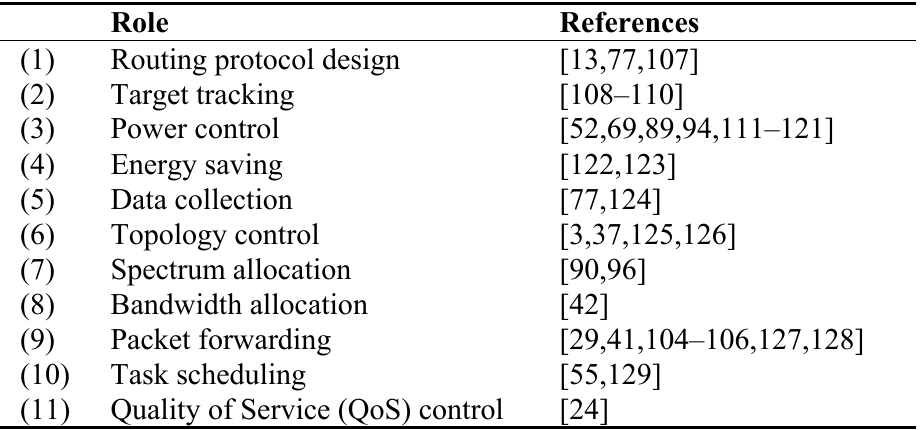
Table 3. The most significant roles of GT in WSN